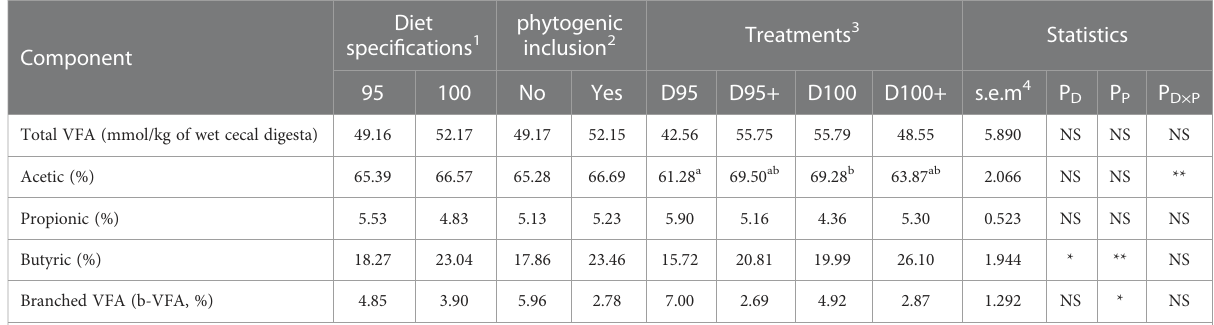
TABLE 4 Effects of diet speci fi cations %, phytogenic inclusion, and their interaction on the volatile fatty acid (VFA) concentration and molar ratios in the cecal digesta of 42-day-old broilers.